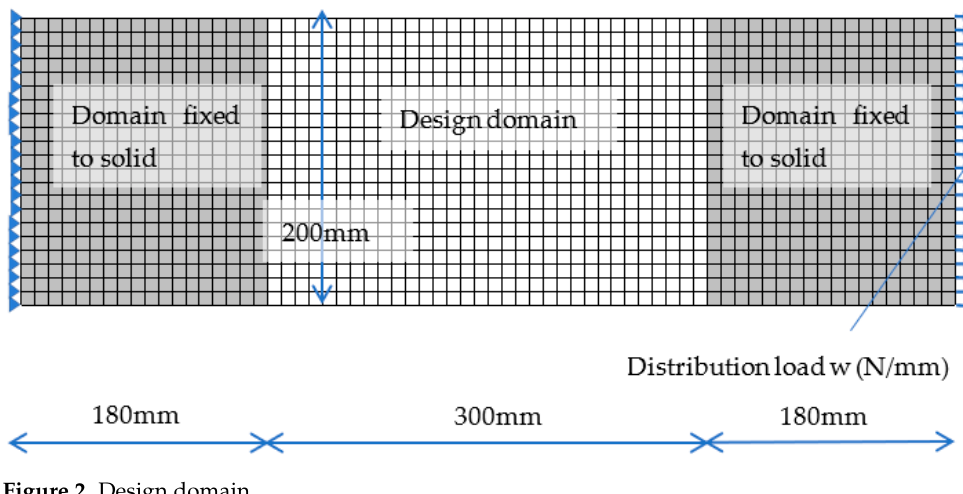
Figure 2. Design domain. Table 1. Non-dominated final solutions by NSGA-II with the four-column